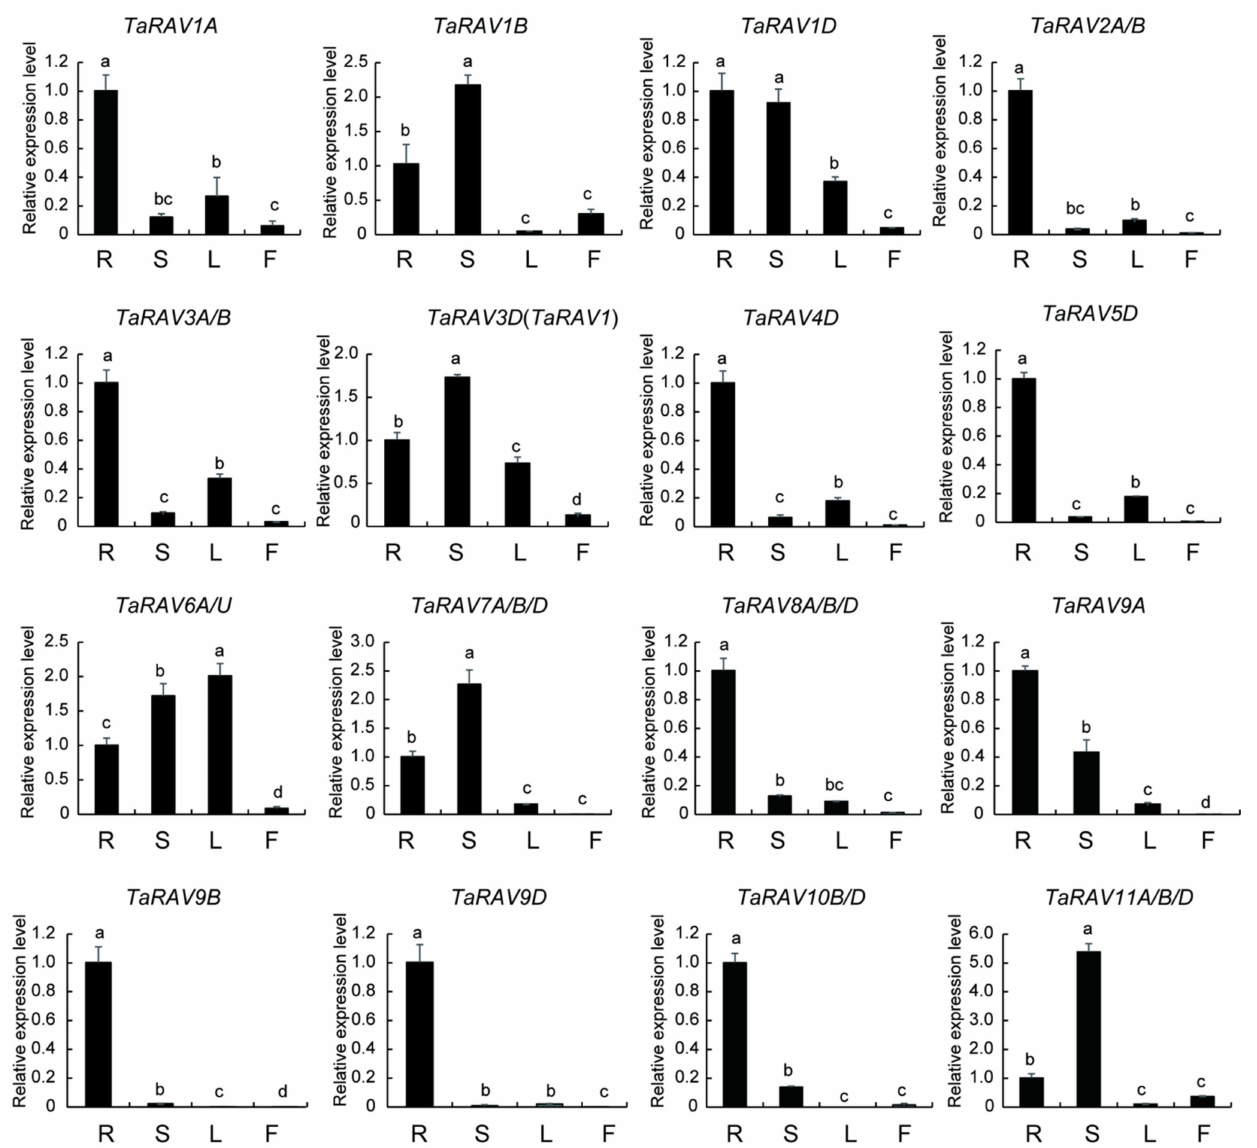
Figure 2. Expression levels of TaRAV genes in different wheat tissues.RNA was extracted from the root (R), stem (S), leaf (L), and inflorescence (F) tissues, and analyzed using the qRT-PCR method. Transcript levels of TaRAV genes were normalized to that of Taactin , and the levels of root samples were set to 1. Data shown are means ± SE, n = 3. Different letters represent significant differences ( p < 0.05, one-way